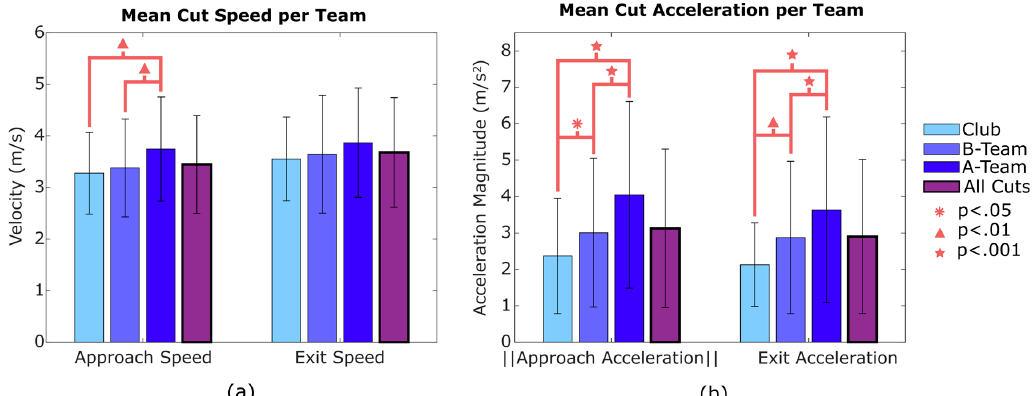
Figure 7. Mean and standard deviation for speeds ( a ) and accelerations ( b ) in approach and exit footfalls for each team. Pooled means for all cuts observed (across all teams) are also included. The A-team players performed cuts with greater speed and acceleration. Approach accelerations are shown as absolute values (raw values are negative).